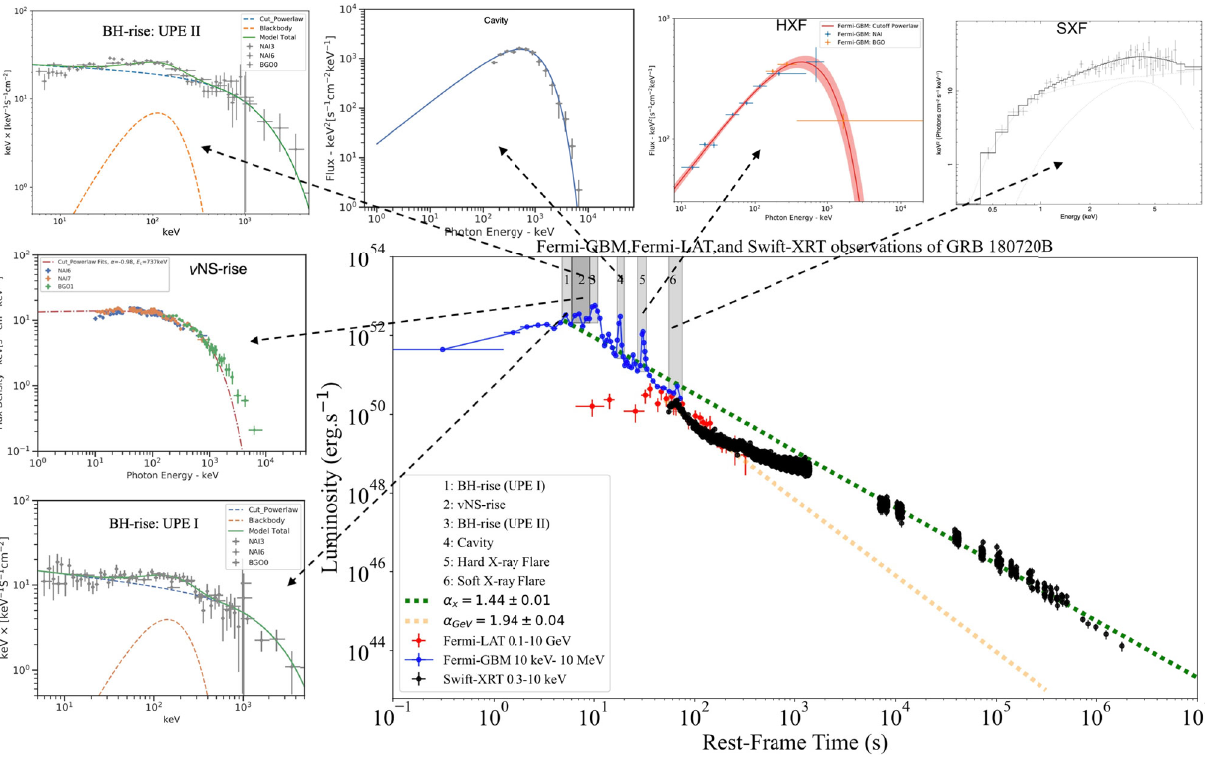
Fig. 2 Luminosity light-curves and spectra related to the different Episodes identified in GRB 180720B. Plots and best fits are reproduced from [36] by the author’s